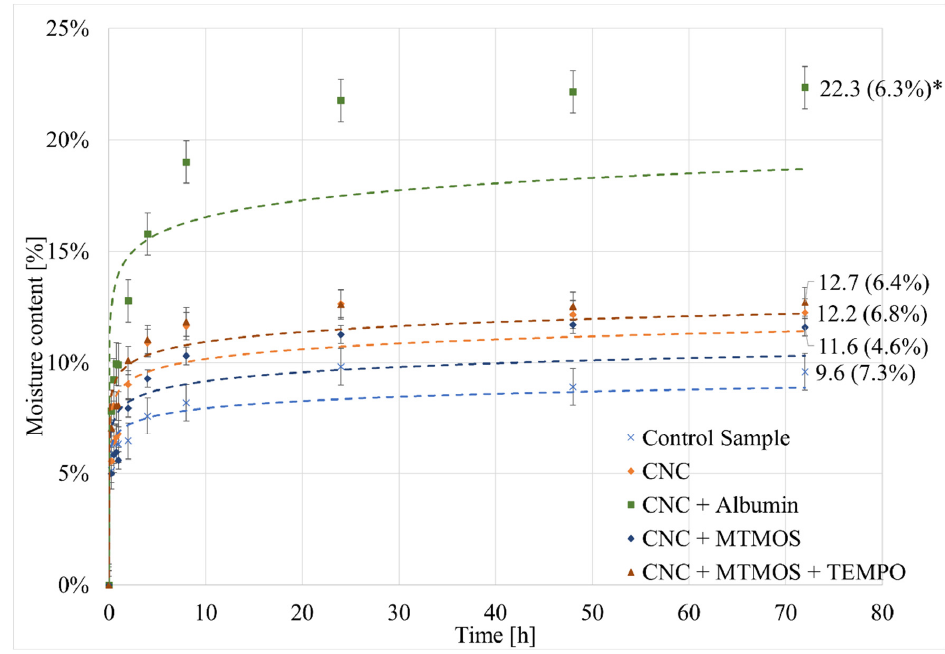
Figure 3. Moisture content (%) of tested CNC samples. * The relative standard deviation (RSD) (%) values are shown in parentheses.